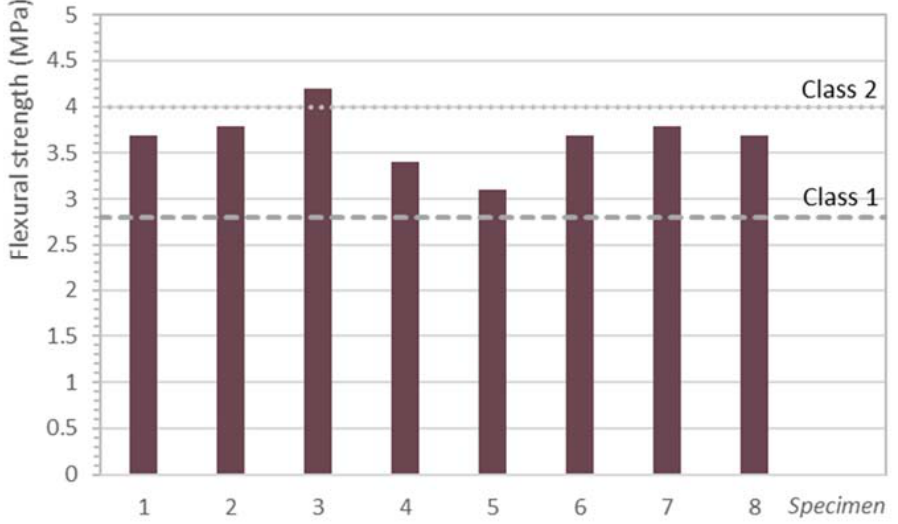
Figure 4. Flexural strength in eight RACC kerbs and minima specified in standard EN 1340 .